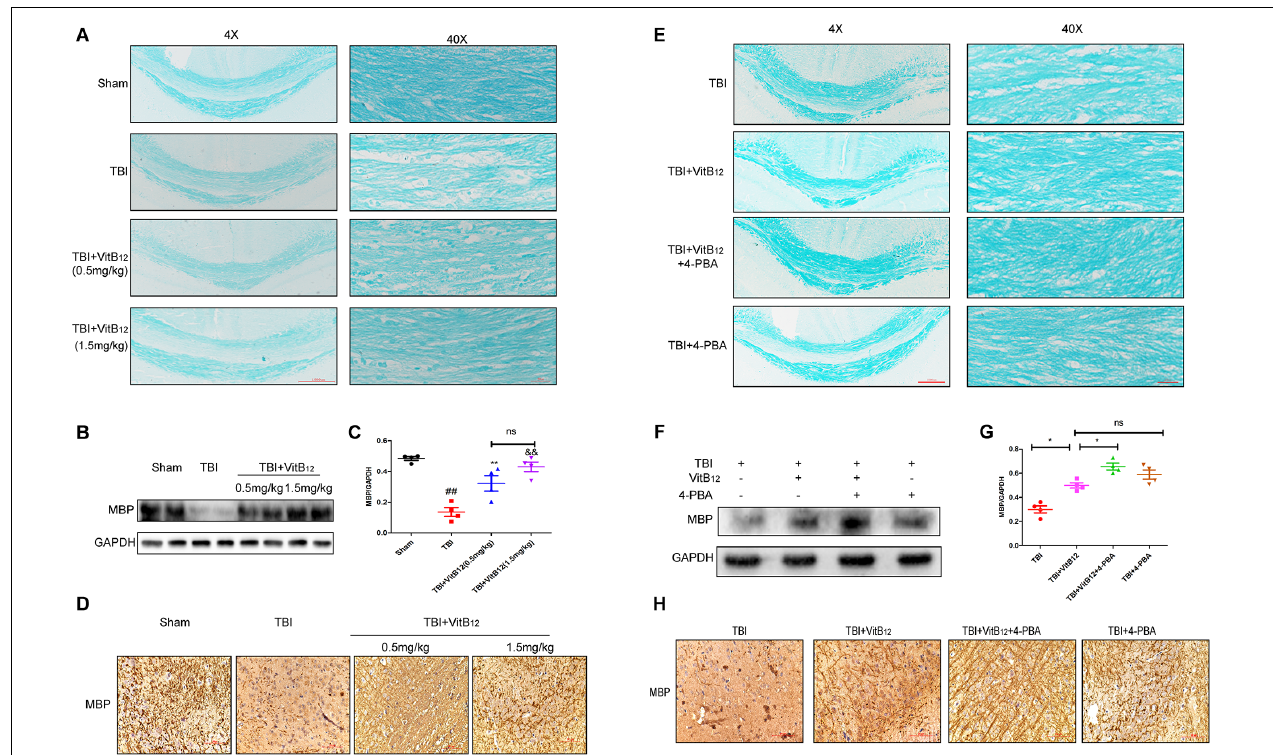
FIGURE 5 | Vitamin B12 protects against myelin damage after TBI through ER Stress. (A) Representative images of white matter with LFB staining images of the myelin sheath at 14 days. Scale bar = 1000 µ m, Scale bar = 250 µ m. (B,C) Protein expressions and quantification data of MBP in each group. ## P < 0.01 vs. the sham group, ∗∗ P < 0.01 and && P < 0.01 vs. the TBI group. Values represent the mean ± SEM, n = 4. (D) Immuno-histochemisty staining of MBP in each group. (E) Representative images of white matter with LFB staining images of the myelin sheath at 14 days. Scale bar = 1000 µ m, Scale bar = 250 µ m. (F,G) Protein expressions and quantification data of MBP in each group. ∗ P < 0.05 vs. the indicated group values represent the mean ± SEM, n = 4. (H) Immuno-histochemisty staining of MBP in each